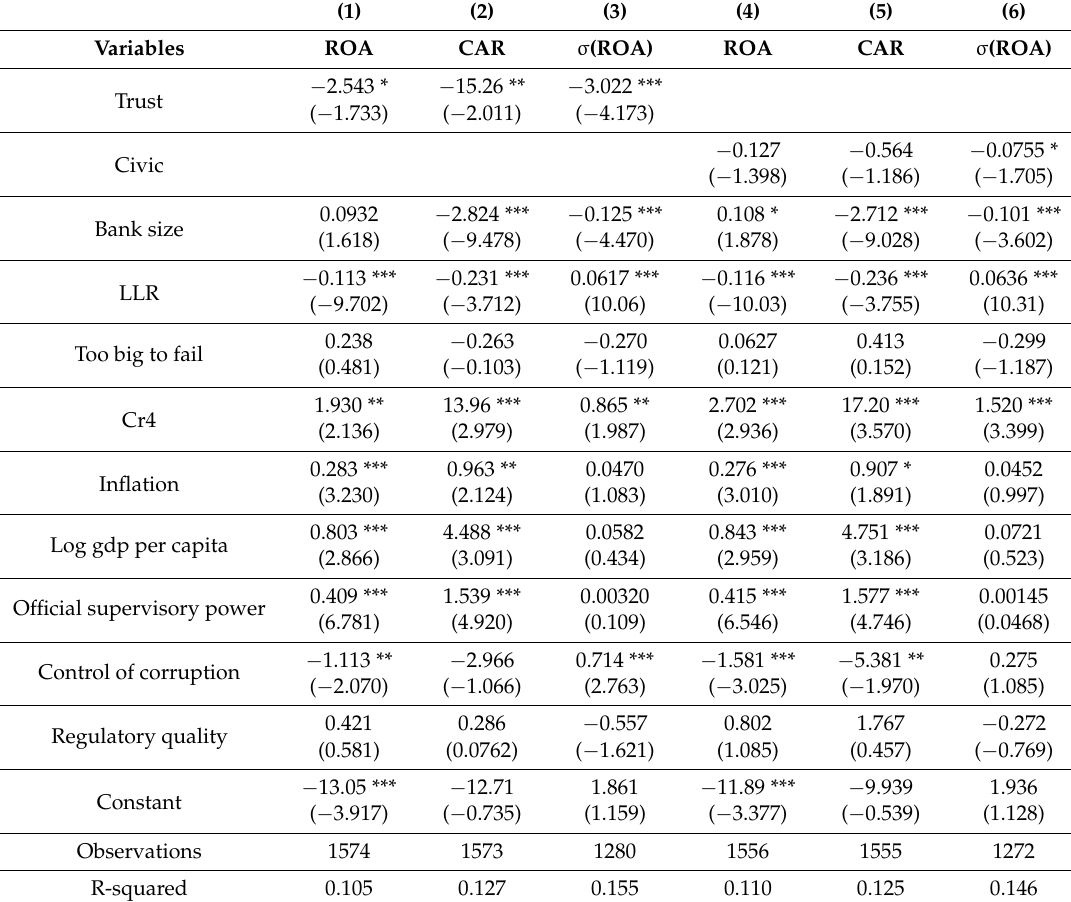
Table 7. Three components of Z-score as dependent